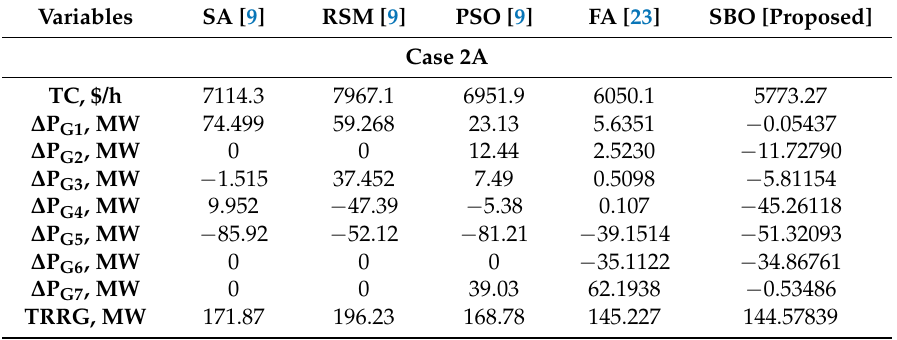
Figure 3. Simulation results for Case 2A. ( a ) voltage magnitude in p.u.; ( b ) change in real-power in MW; ( c ) congestion cost in $/h; ( d ) convergence profile. Table 4. Comparison of simulation results for modified IEEE 57-bus test power system.